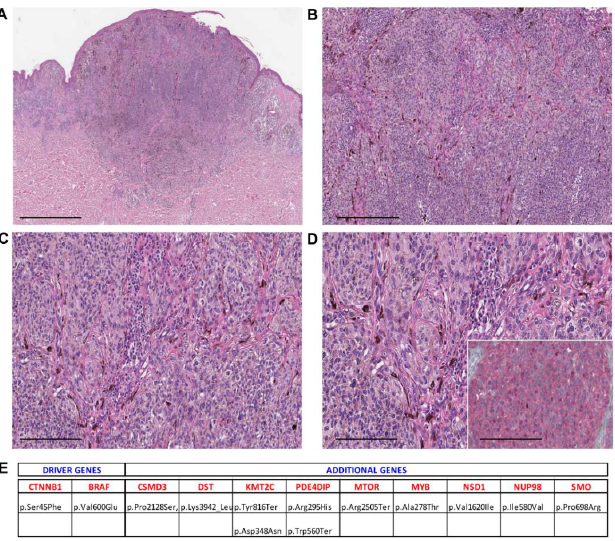
Figure 3. Case 9—male, 16 years old, back. ( A ) Wedge-shaped silhouette of a pigmented combined melanocytic tumor involving the dermis (40×, scale bar 500 µm); ( B ) fascicles and large aggregates of plump oval and epithelioid melanocytes combined with ovoid conventional melanocytes (100×, scale bar 100 µm); ( C ) oval melanocytes show a pale or dusty cytoplasm and contain fine melanin granules (200×, scale bar 50 µm); ( D ) oval melanocytes with hyperchromatic nuclei and pseudo-nuclear inclusions are seen intermingled with cytologically bland conventional melanocytes (400×, scale bar 25 µm). Inset: β-catenin staining shows nuclear positivity (400×, scale bar 25 µm). ( E ) Mutational profile: driver gene mutations and additional pathogenic alterations.